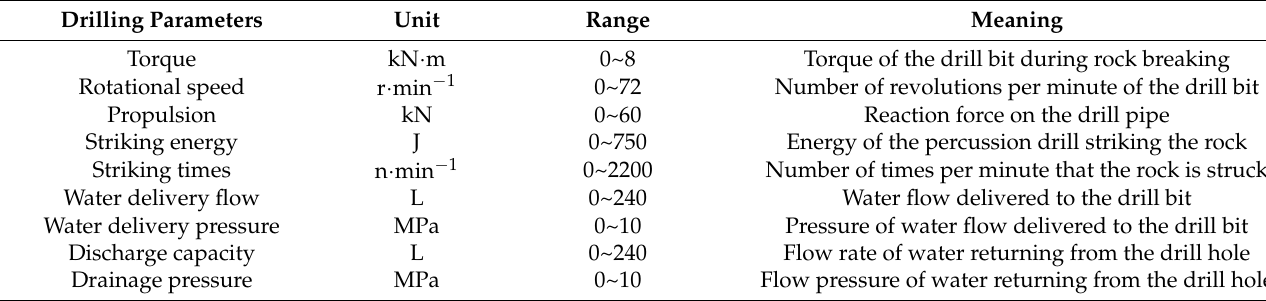
Table 2. Samples of drilling parameters in the Qingdao Jiao Zhou Bay Subsea Tunnel.